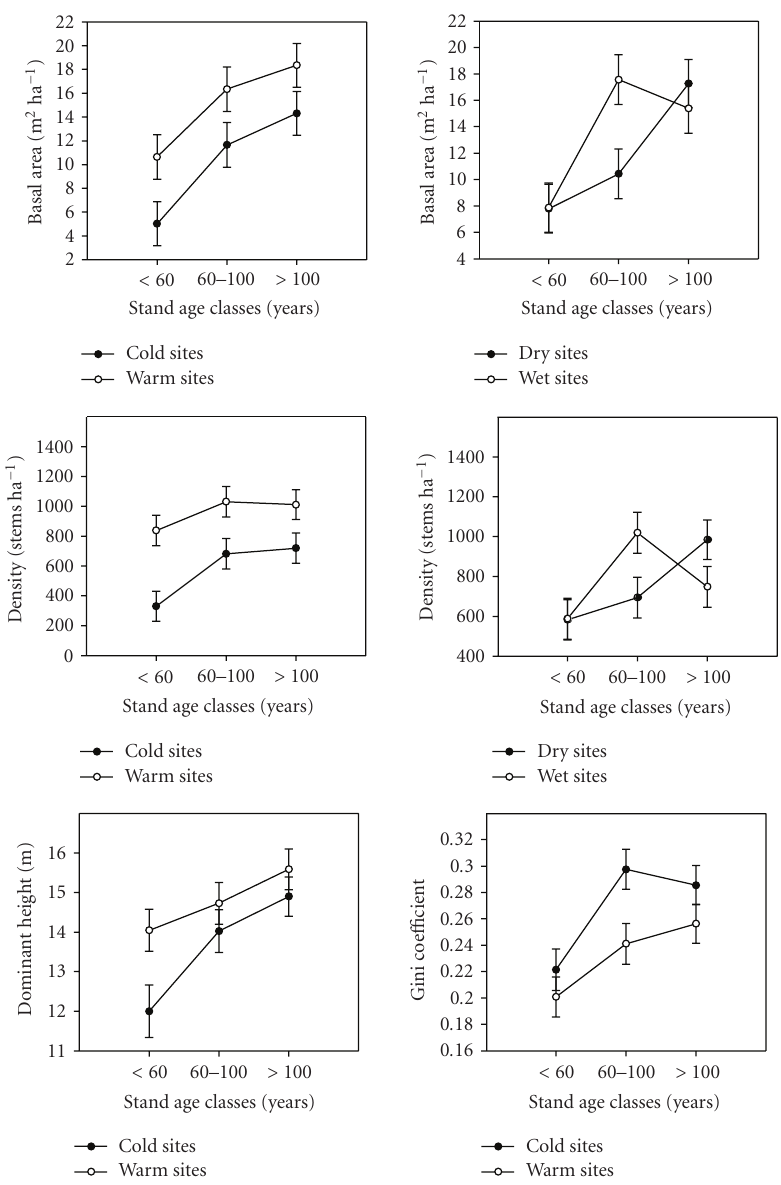
Figure 4: Relationships between stand structure and stand age, air temperature, precipitation, and soil texture. Data from the first inventory